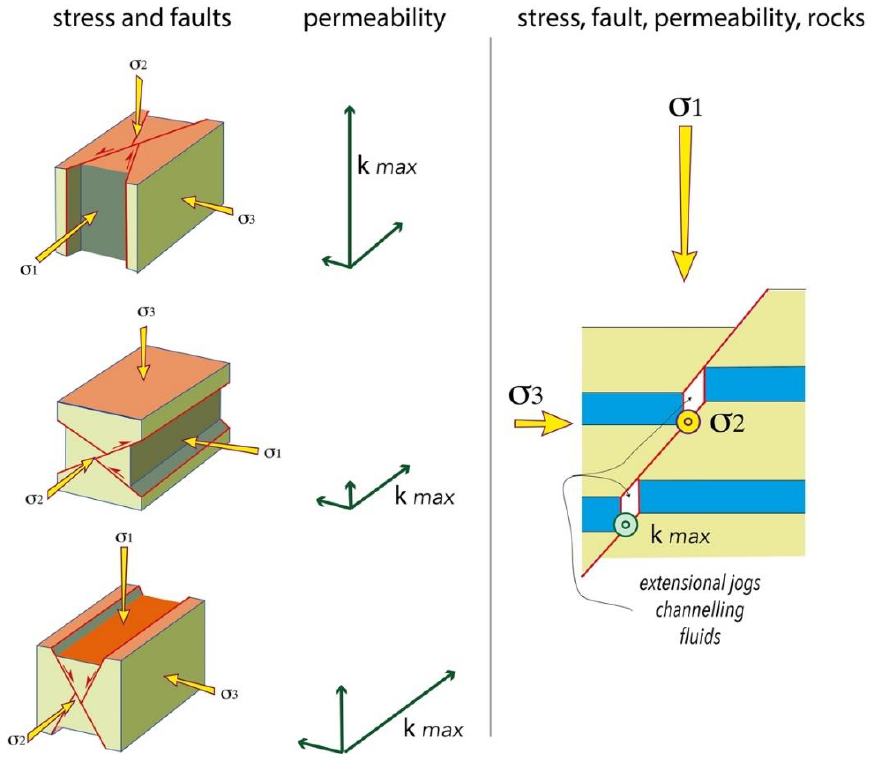
Figure 4. Relationships between the main stress axes in the Andersonian theory and the direction along which permeabil- ity (k) is favored (after Reference